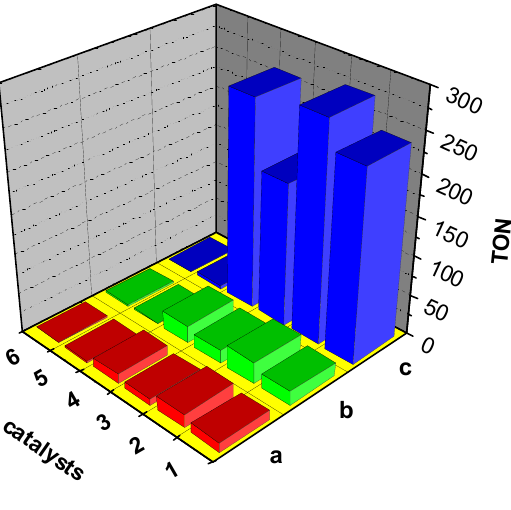
Figure 5. Turnovers numbers of catalytic cycles for 1 – 6 using the standard conditions detailed in Section 3.5 (a); increasing the [H (b); reducing the [complex] adding 1 μ L 10 − 3 M instead of 10 μ L